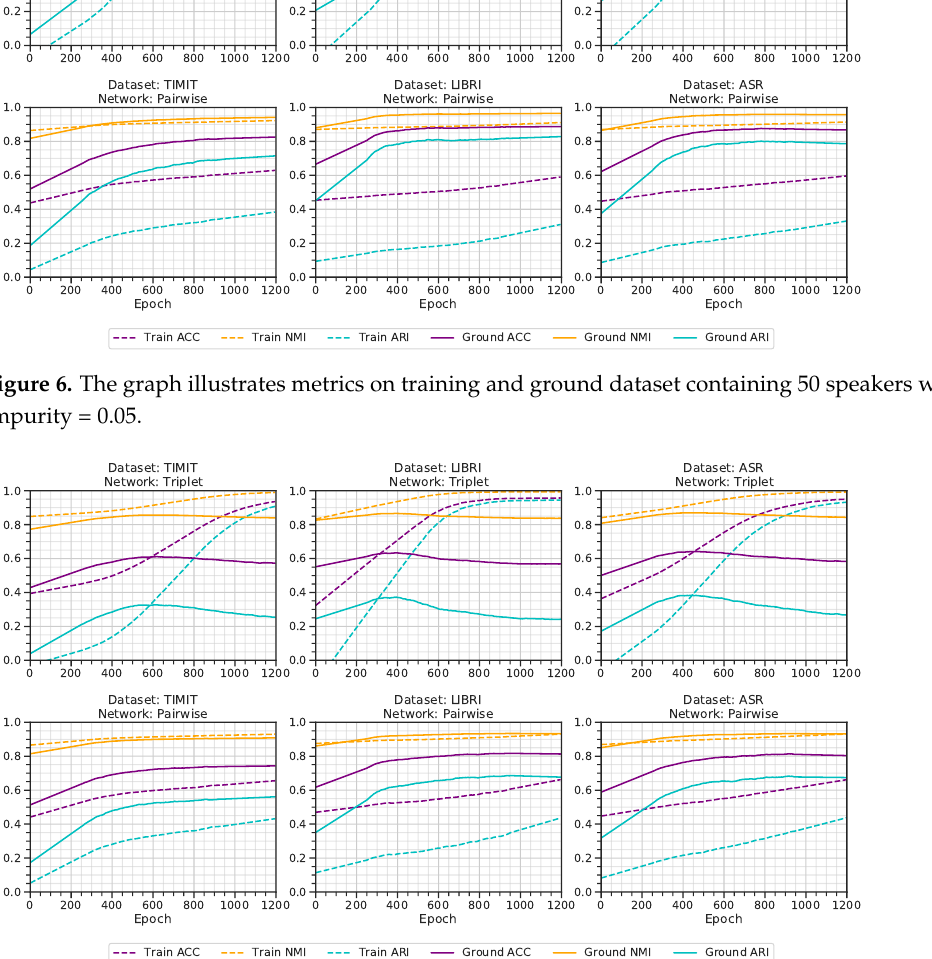
Figure 7. The graph illustrates metrics on training and ground dataset containing 50 speakers with impurity =